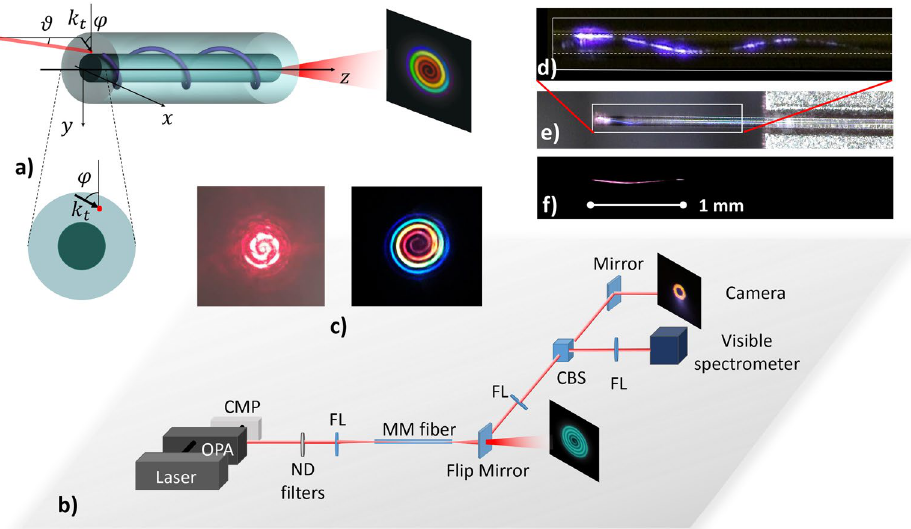
Figure 2. ( a ) Schematic of fibre geometry and rainbow spiral emission; ϑ is the incidence tilt of the skew ray (or zenith angle), ϕ is the azimuth angle, and k t is the projection of the laser beam wave vector on the fibre transverse plane. ( b ) Schematic of set-up where typical near- and far-fields are shown. The ND filter is used to vary input power, FL stands for focus lens, and CBS for cubic beam splitter. ( c ) Spiral emission from CW He–Ne laser (left) or from femtosecond pulse laser (right). ( d ) Zoom-in of ( e ), dashed lines indicate core– cladding boundaries. ( e ) Visualization of helical beam propagation in a graded-index (GRIN) fibre, thanks to upconversion luminescence from material defects and doping. Scattered white light on the right is due to the fibre holder. ( f ) Same as ( d ) but from step-index